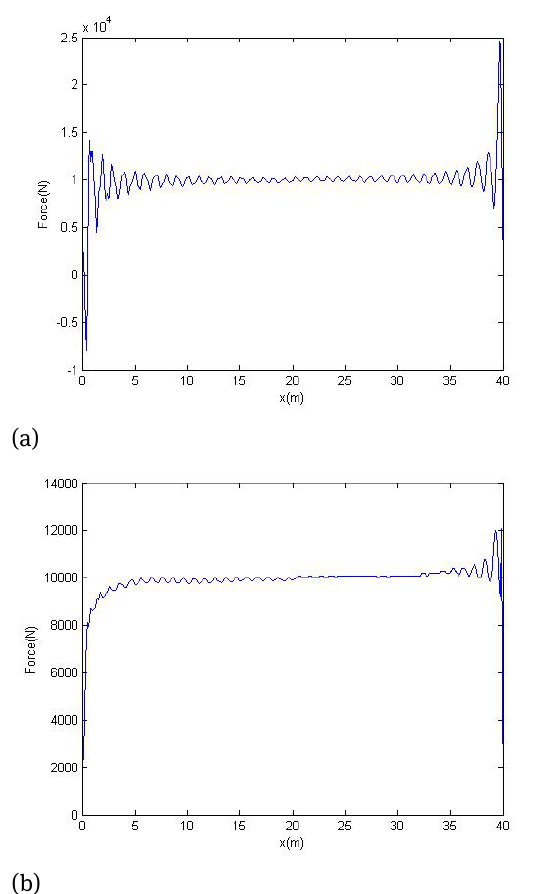
Fig. 3. Acceleration of the mid-span point. Fig. 4.